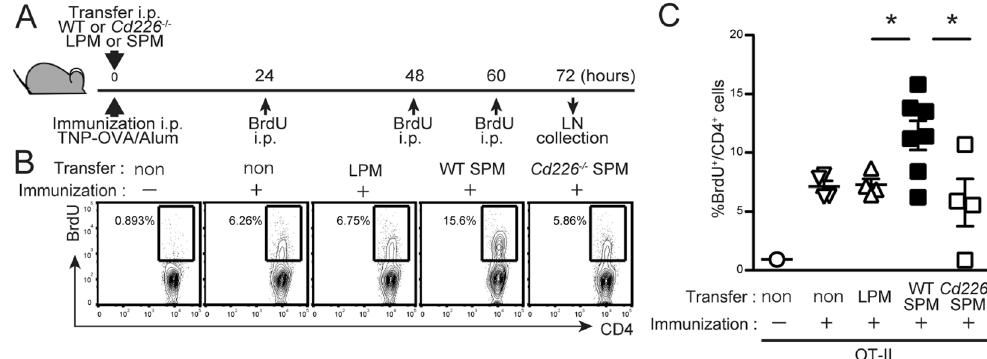
Figure 4. DNAM-1 on SPMs contributes to T cells proliferation in mediastinal lymph nodes after immunization. ( A – C ) OT-II Tg recipient mice were transferred i.p. with 4 × 10 4 of LPMs or WT or Cd226 − / − SPMs and immunized i.p. with TNP-OVA/Alum and cells proliferation were traced by injecting BrdU as shown in Materials and Methods. After 72 hrs, mediastinal LNs were collected; the frequencies of dividing CD4 + T cells were defined as the percentage of BrdU + cells in CD3 + CD4 + cells. Nuclei were stained with APC- conjugated anti-BrdU mAb by using a BrdU Flow Kit (BD Biosciences). Schematic view of the experiment ( A ). Representative plots of BrdU staining ( B ). Scatter plot showing data combined from two independent experiments ( C ); SEM, * P < 0.05.